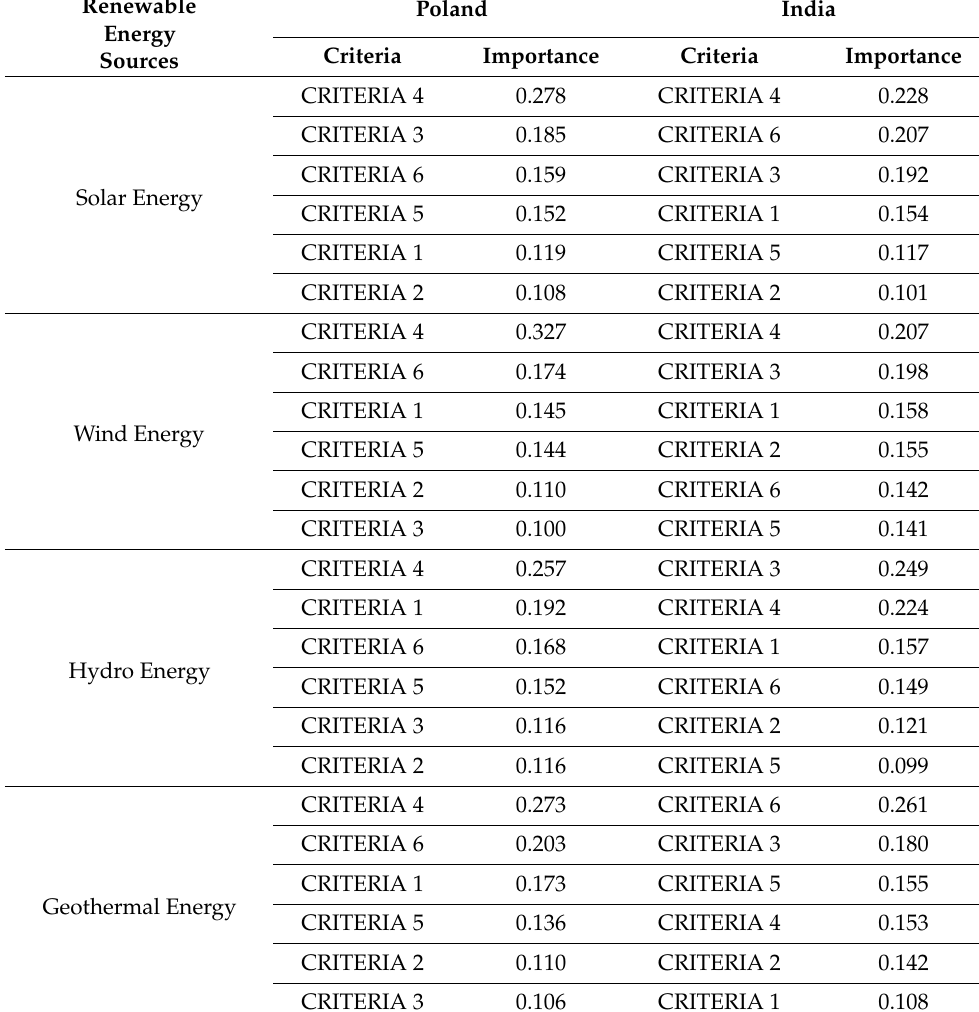
Table 3. Renewable Energy Green Consumer Values Poland and